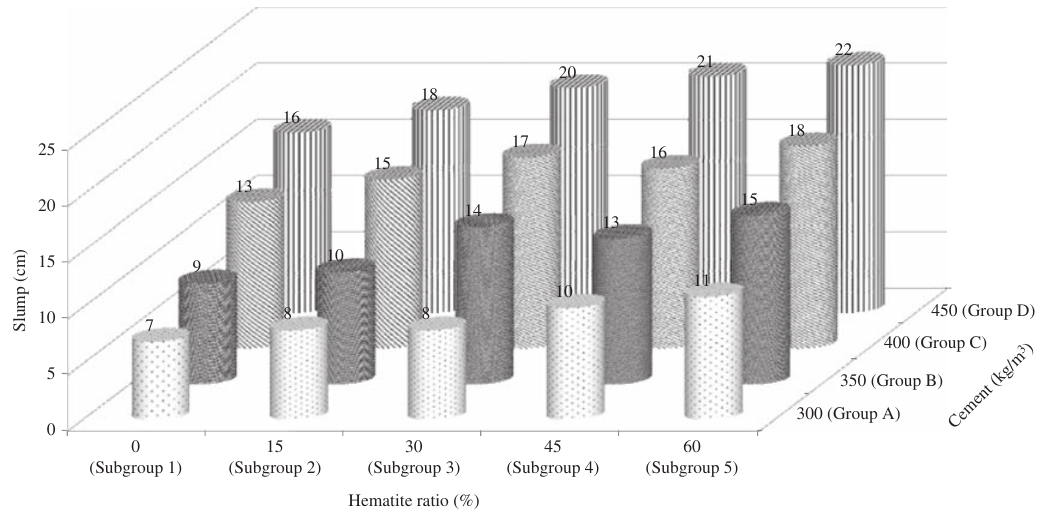
Figure 4 Slump variations of concrete with hematite and cement contents.